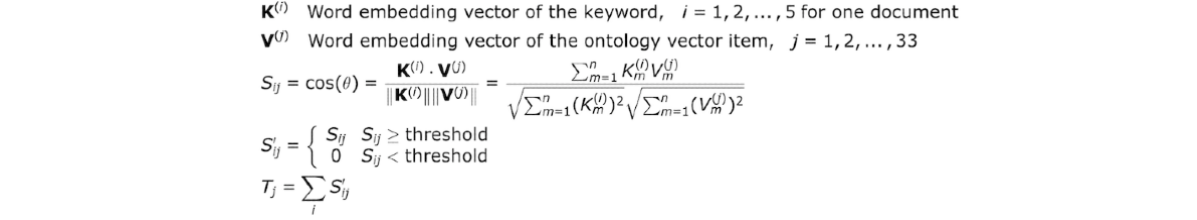
Figure 4. Concrete calculation process of the text vector.